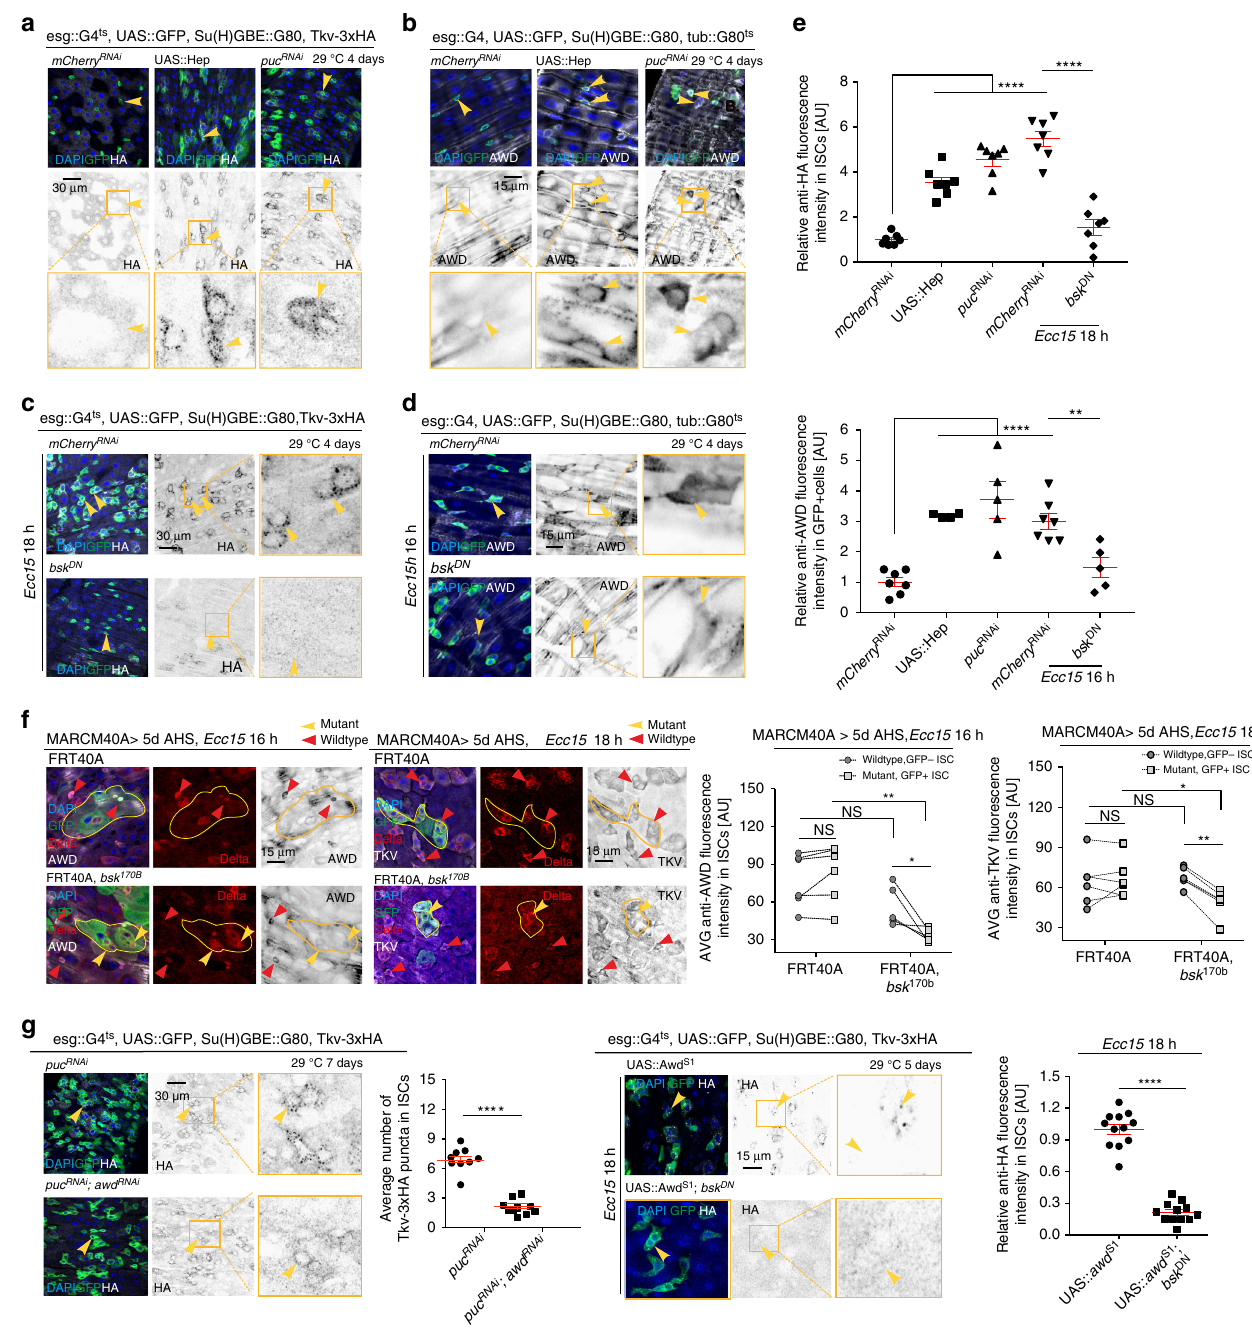
Fig. 4 JNK signaling promotes Tkv internalization through AWD in ISCs. a , b Expression of Tkv-3xHA ( a ) or AWD ( b ) in ISCs (arrowheads, GFP + ) determined by immunohistochemistry, when JNK was activated by overexpressing JNK Kinase ( hep ) or knocking down puckered ( puc ) for 4 days. c , d Expression of Tkv-3xHA ( c ) and AWD ( d ) in ISCs (arrowheads, GFP + ) upon 18 h Ecc15 infection, when JNK signaling was deactivated by overexpressing a dominant negative form of JNK ( bsk DN ) in ISCs. e Normalized average intensity levels of Tkv-3xHA and AWD in ISCs per posterior midgut (PM) under conditions of a – d (normalized to the mean values of control samples expressing mCherry RNAi ). f Differential expression of AWD or TKV protein between bsk mutant ISCs (DELTA + , GFP + , indicated by yellow arrowheads) and wildtype ISCs (DELTA + , GFP − , indicated by red arrowheads) after Ecc15 challenge. Lines connect data for wildtype and mutant ISCs from same guts in quanti fi cation. g Tkv-3xHA expression in puc RNAi ISCs (arrowheads, GFP + ) with and without awd loss of function. Tkv-3xHA punctum numbers were quanti fi ed. h Expression level of Tkv-3xHA in awd overexpressing ISCs with and without deactivating JNK signaling by co-expressing bsk DN , measured as the average HA intensity in ISCs after 18 h Ecc15 infection. Quanti fi cations were normalized to the mean values of samples overexpressing awd alone. Error bars indicate SEM ( e n = 7 fl ies, f n = 5 – 7 fl ies, g n = 9 – 11 fl ies, h 12 fl ies). P values were calculated from Student ’ s t -test, except that ratio paired t -test was performed to examine the signi fi cant differences of AWD or TKV expression between wildtype ISCs and bsk 170b ISCs within the same gut ( f ): **** P < 0.0001; ** P < 0.01; * P < 0.05; NS, not signi fi cant. Experiments were repeated 3 times ( a – e , g – h ) or twice ( f